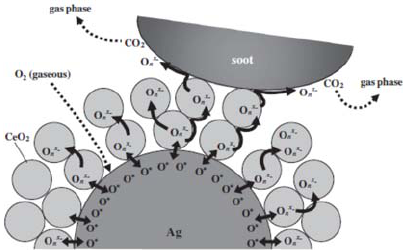
Figure 11. A schematic mechanism for soot oxidation over the CeO 2 –Ag catalyst. Reproduced from Ref. [49] with the permission from the Elsevier.